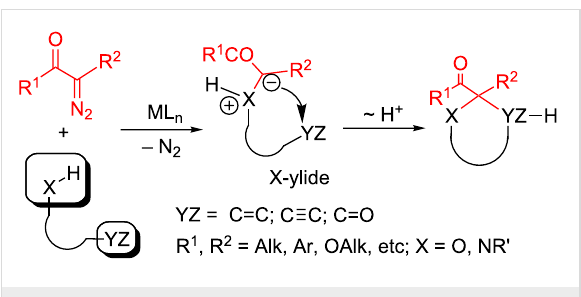
Dirhodium carboxylates [Rh 2 (OAc) 4 , Rh 2 (Oct) 4 and Rh 2 (Piv) 4